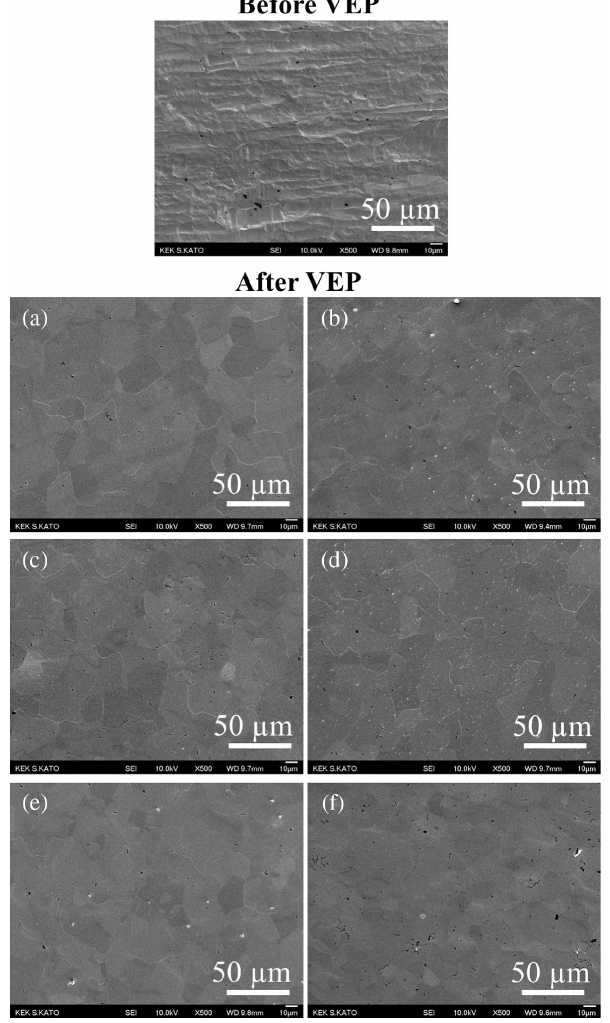
(d) bottom iris, and (e),(f) equator positions for the VEP maximum cavity temperature of 16 °C.